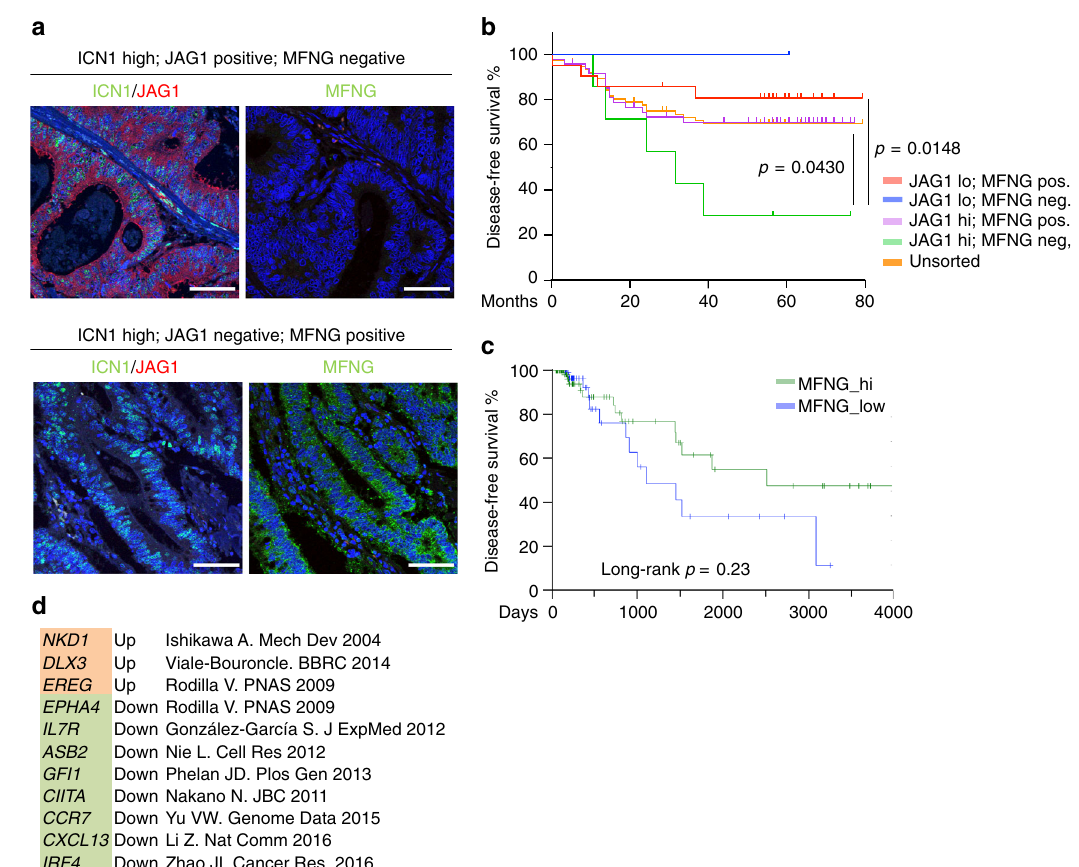
Fig. 5 ICN1, JAG1, and MFNG levels predict CRC patient prognosis. a Representative images of Notch, JAG1, and MFNG staining in two different carcinoma samples. Scale bars represent 75 μ m. b , c Disease-free survival analyses (Kaplan – Meier curves) of the indicated groups of patients determined by IF analysis of our cohort of patients ( b ) or from the TCGA CRC tumors in the subgroup ( c ) with high Notch1 expression that exhibit high (green) or low (blue) expression of MFNG. d Genes previously identi fi ed as Notch targets in the indicated publications that were up- (Up) or downregulated (Down) in the MFNG-low tumors compared to the